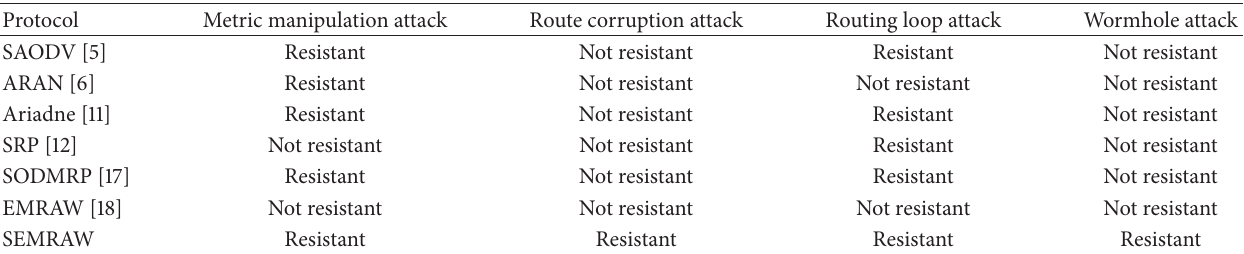
Table 1: Security comparison of different